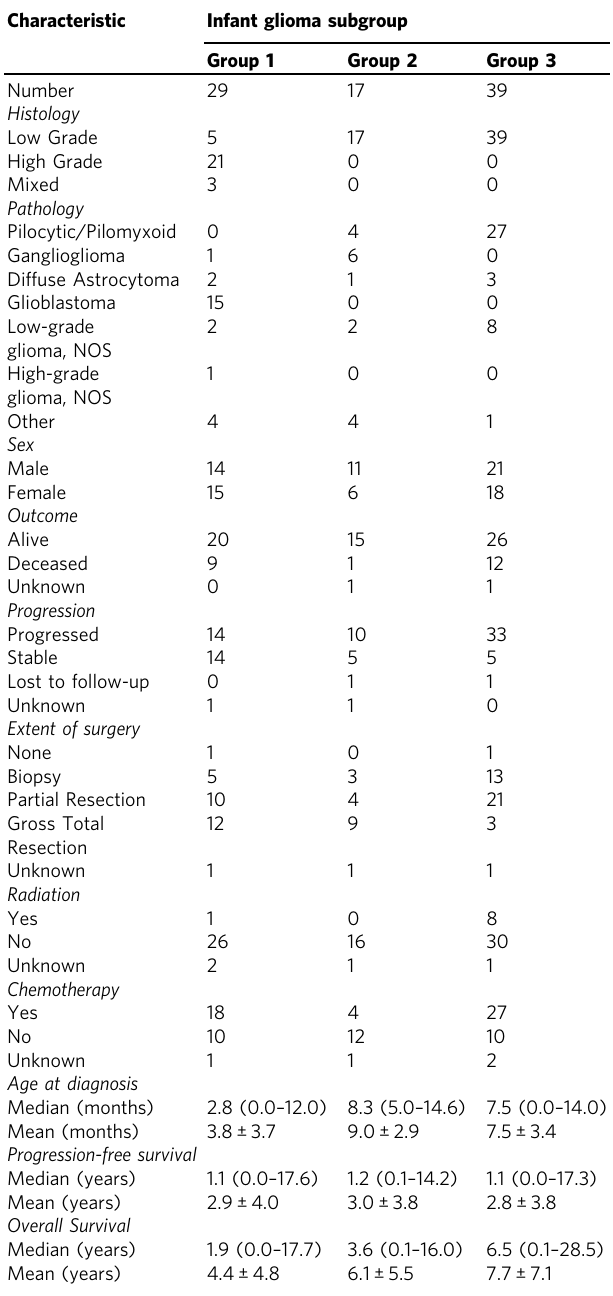
Table 1 Summary of patient characteristics according to infant glioma